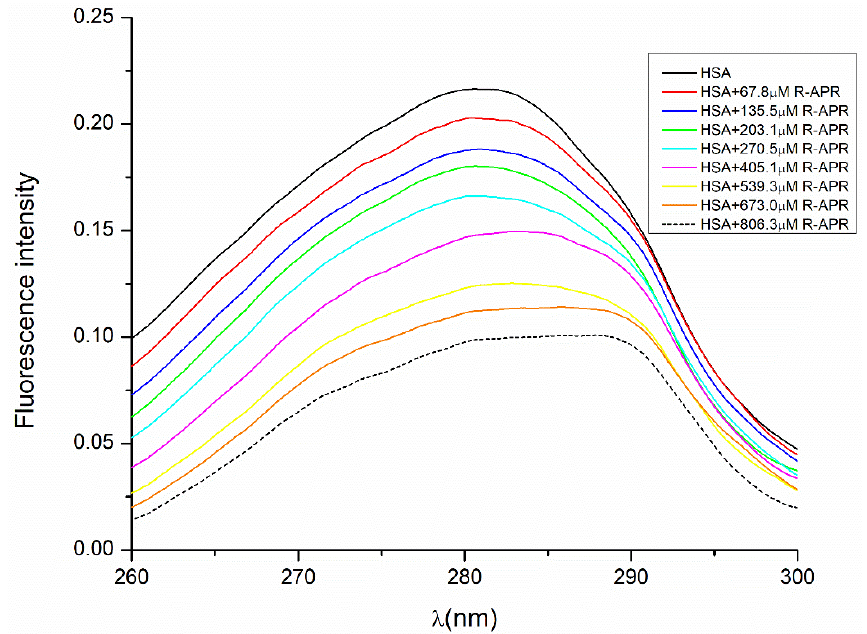
Figure 4. Quenching of HSA fluorescence by R -APR.